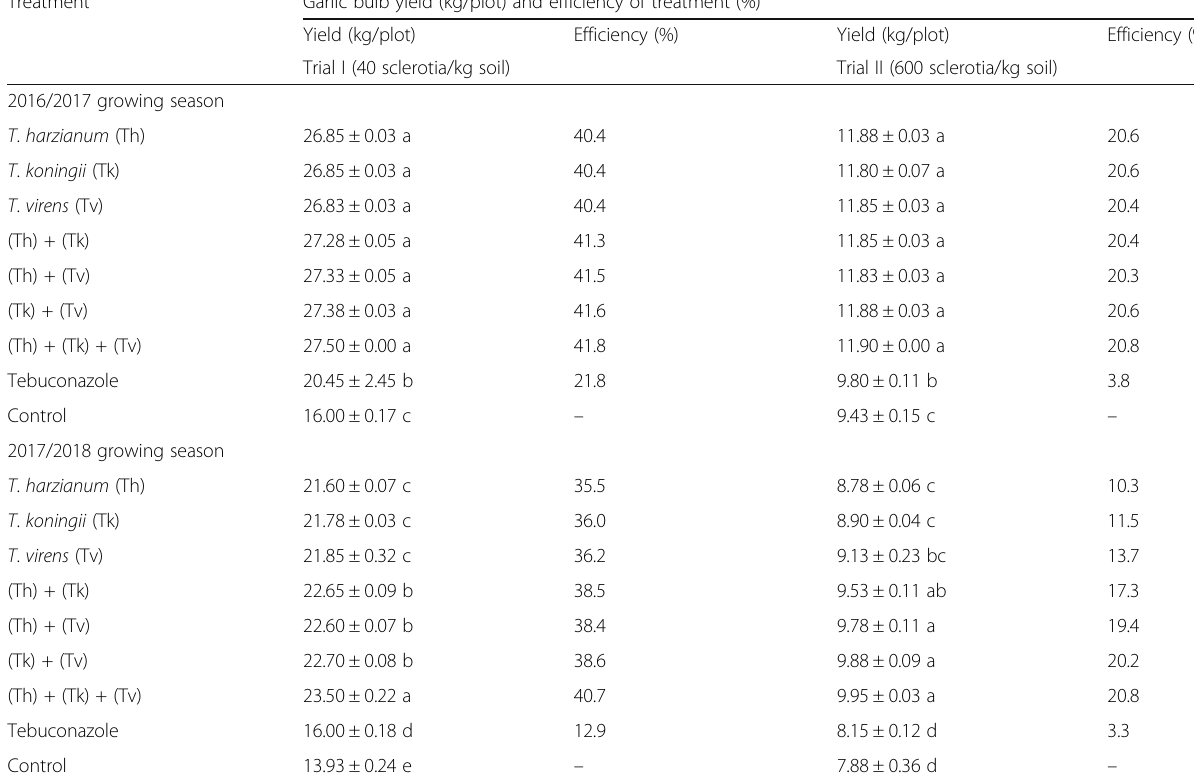
Table 7 Effect of selected Trichoderma strains and their combinations on garlic bulb yield under field conditions Treatment Garlic bulb yield (kg/plot) and efficiency of treatment